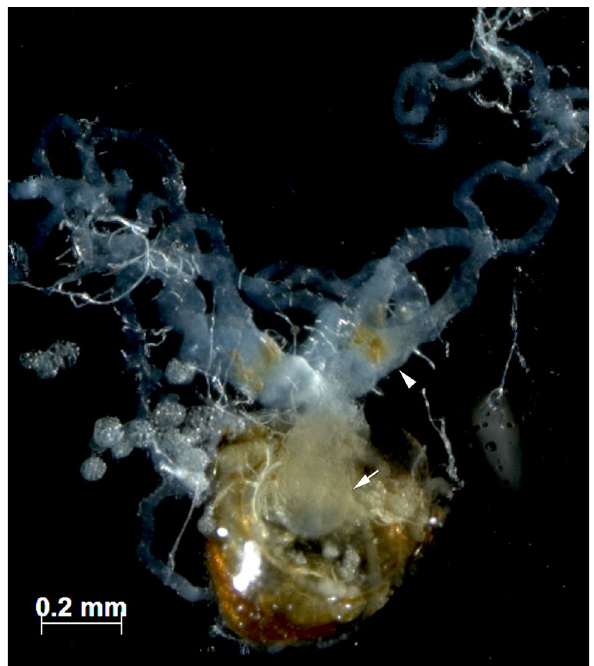
Figure 1. Reproductive organs of an asexually reproducing queen of the fungus-growing ant Mycocepurus smithii . The spermatheca is translucent indicating that it was empty (arrow), the ovaries are developed, and the presence of yellow bodies indicates that the queen was actively laying eggs (arrowhead).